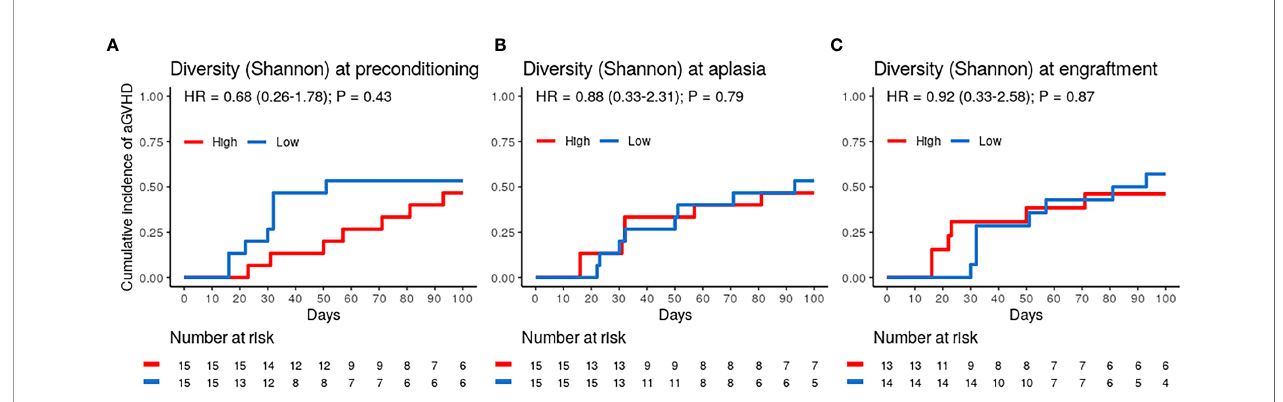
FIGURE 2 | Dental bio fi lm microbiota alpha diversity is not associated with the risk of acute graft-versus-host disease (aGVHD). (A – C) Cumulative incidence of aGVHD with patients strati fi ed by Shannon diversity index (High vs. Low) at preconditioning ( A ; n = 30), aplasia ( B ; n = 30) or engraftment ( C ; n